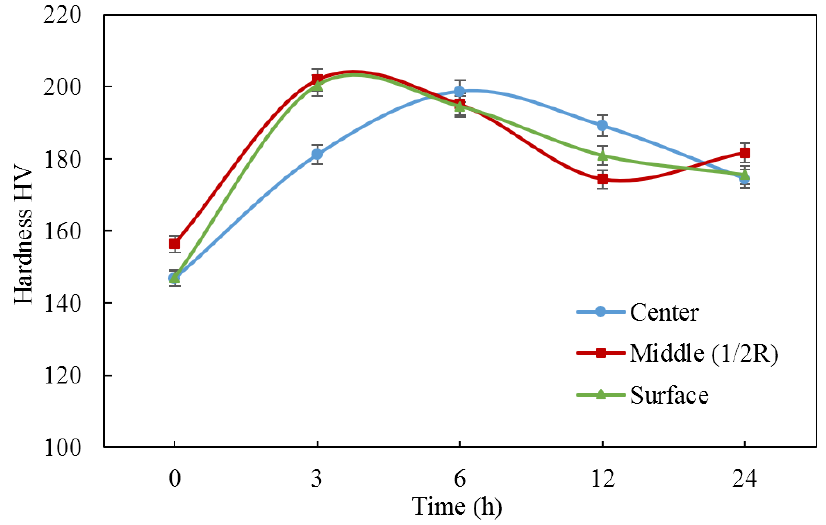
Figure 10. Hardness of experimental alloy (RSR) vs. aging time at 150 °C (solution treatment at 450 °C, 1 h + water cooling).